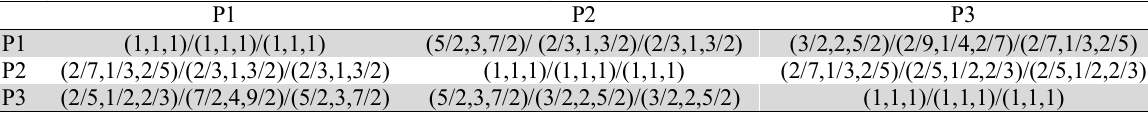
Linguistic Evaluations of Alternatives According to SC/CO/AG